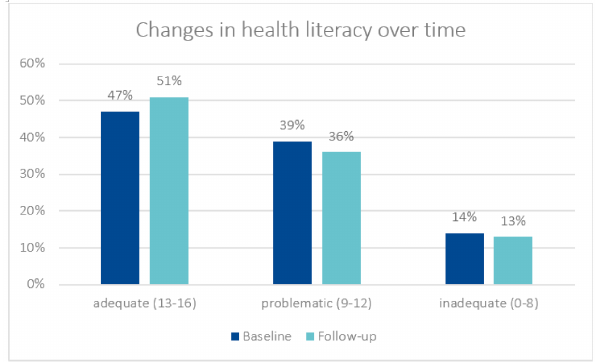
Figure 1. Changes in health literacy over time ( p =